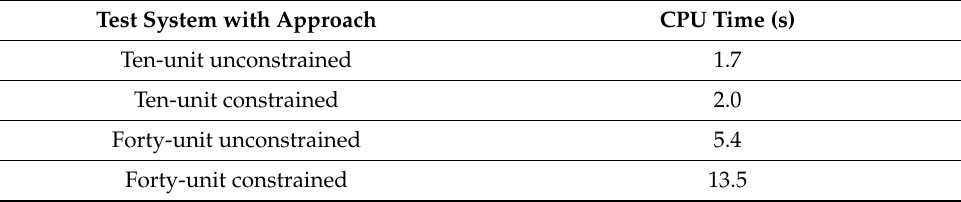
Table 6. CPU time